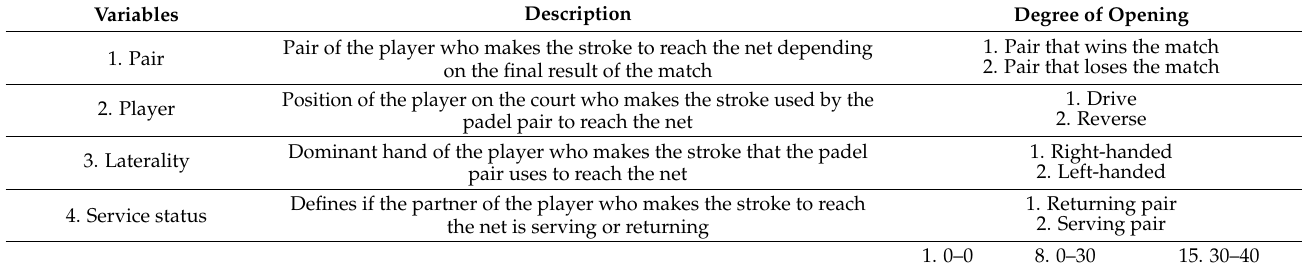
Table 2. Category system of the NAPOA